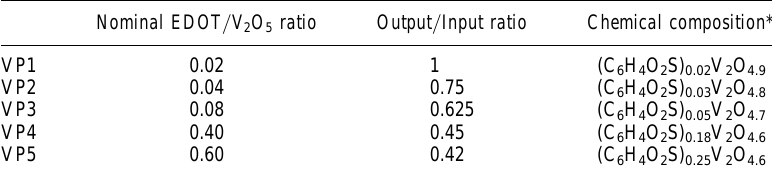
TABLE II Nominal EDOT = V 2 O 5 Ratio and Corresponding Chemical Composition for the Hybrid Samples.